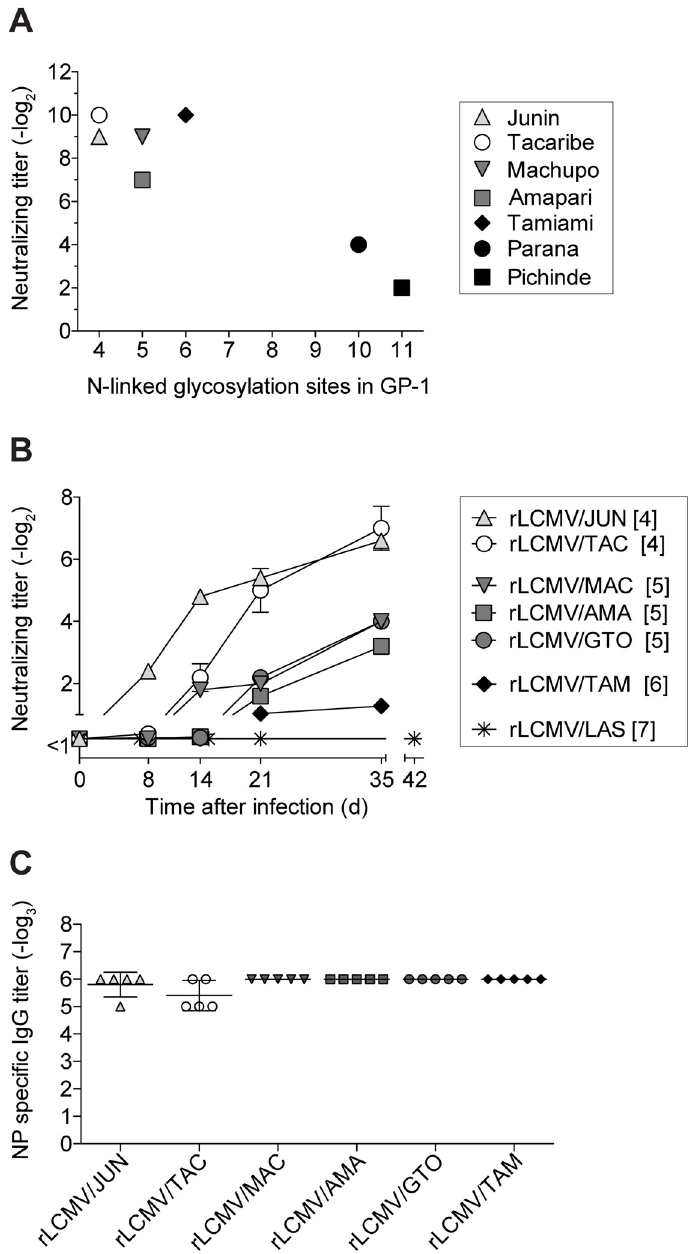
Fig 1. nAb response kinetics against Clade B arenavirus envelopes correlate with GP-1 glycan density. (A) Neutralization titer data published by Trapido et al . in 1971 [37] are plotted in relation to the number of N-linked glycosylation motifs in the respective virus ’ GP-1 (according to Genbank accession numbers as listed in Table 1). Trapido et al . had tested the antiviral neutralizing potency of hamster serum obtained upon hyperimmunization with the respective viruses. (B-C) We infected C57BL/6 mice i.v. with 2x10 5 PFU of the indicated recombinant LCM viruses carrying a range of clade B arenavirus GPs. rLCMV/ LAS data originate from a separate experiment and are included for comparison. The number of GP-1 N- linked glycosylation motifs is indicated in brackets. (B) Serum samples were tested in neutralization assays against the respective virus used for infection. Symbols represent the mean ± SEM of five mice per group. One of two similar experiments is shown. (A-B) Neutralizing titers were determined in 8-fold (A) or 10-fold (B) pre-diluted serum. (C) LCMV-NP specific IgG titers were determined in 100-fold pre-diluted serum on d35. Individual data points and the mean ± SEM of five mice per group are shown.